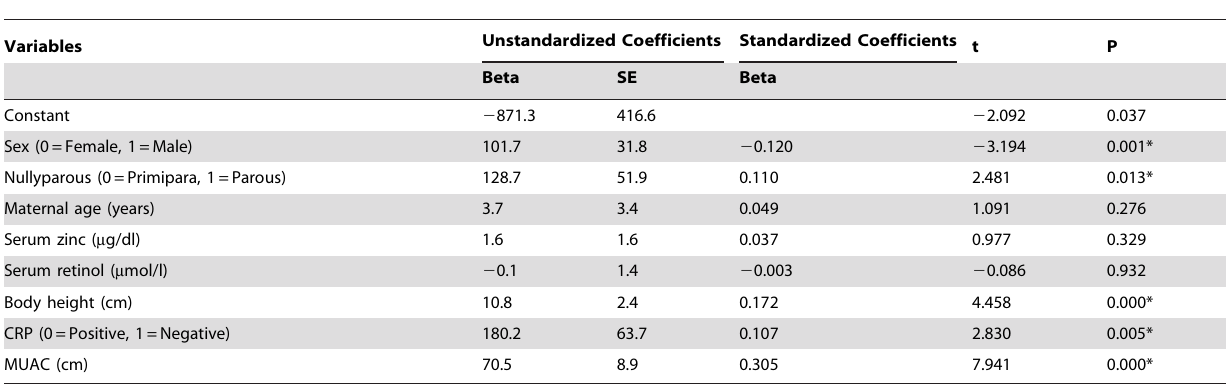
Table 4. Output of the linear regression analysis on predictors of LBW in rural Sidama, Southern Ethiopia Jan–Oct 2011.